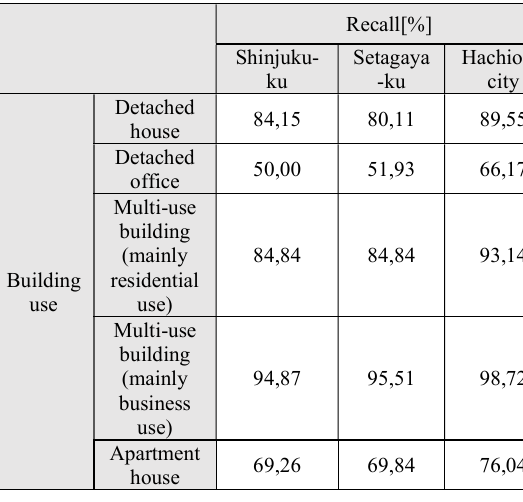
Table 6. Recall per building use